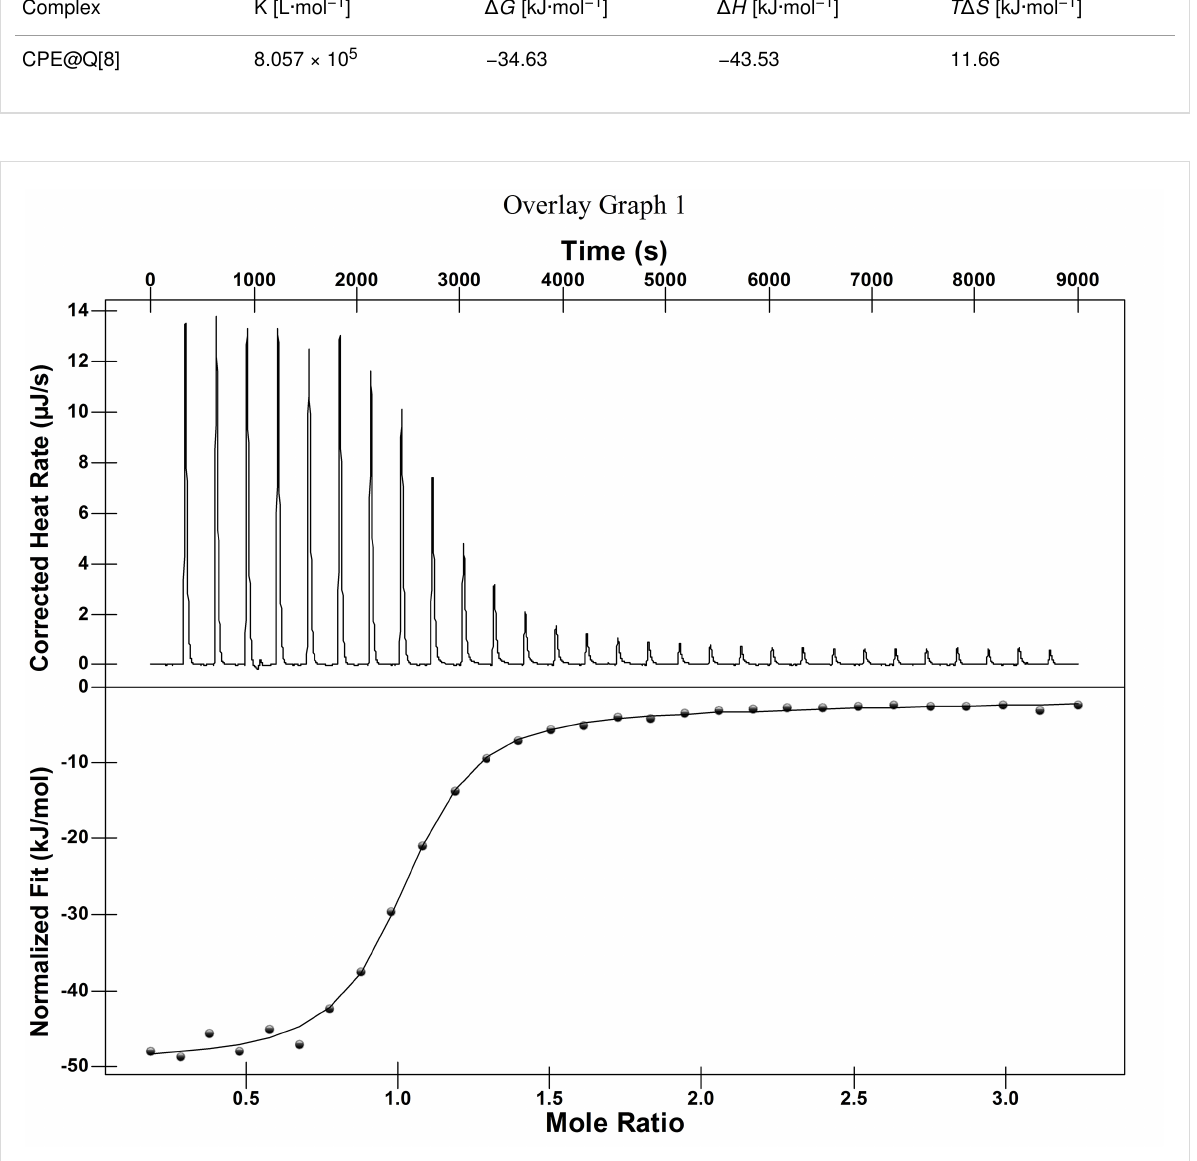
Figure 4: ITC data obtained for the binding of Q[8] with CPE in an aqueous solution at 25